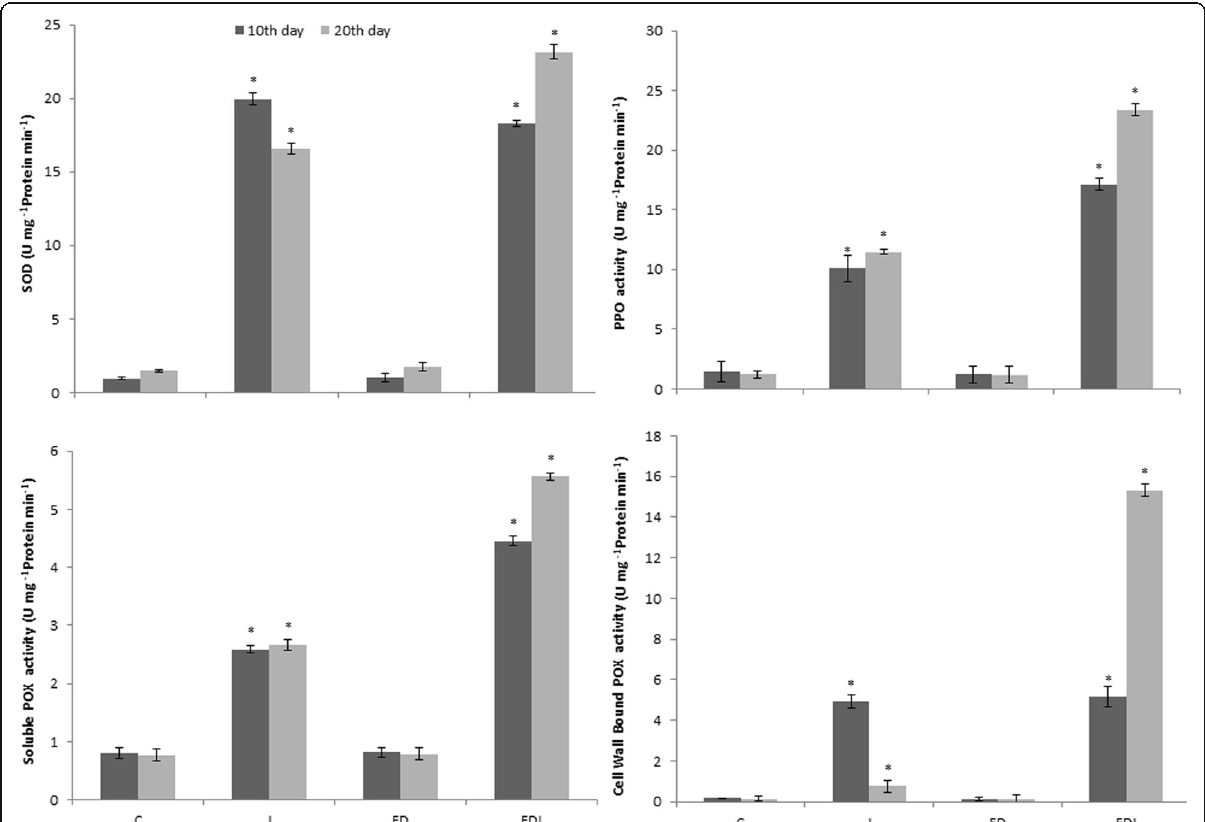
Fig. 3 Effect of defensin priming on antioxidant enzymes (SOD, PPO, soluble and cell wall bound POX) in plants under Fusarium infection. C: Control plants (plants grown from non-primed grains in non-infected soil, FD: plants grown from defensin primed grains in non-infected soil, I: plants grown from non-primed grains in Fusarium infected soil and FDI: plants grown from defensin primed grains in Fusarium infected soil. The columns followed by asterisks are significantly different from the control according to paired-samples t test. The bars represent the standard error. Values are means of three